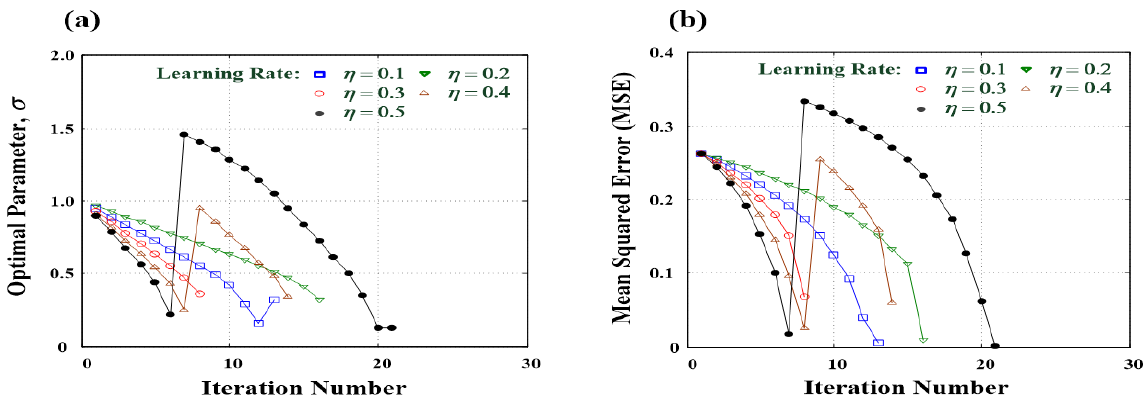
Figure 8. Training history curves for training the multilayer classifier. ( a ) Optimal parameters versus iteration numbers, ( b ) mean squared errors versus iteration numbers.